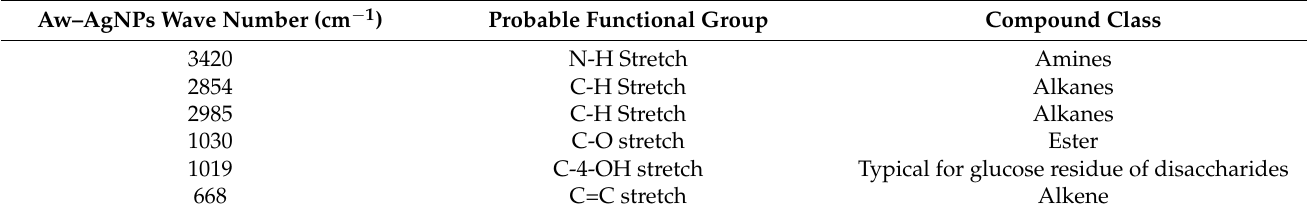
Table 1. FTIR analysis and probable functional groups.